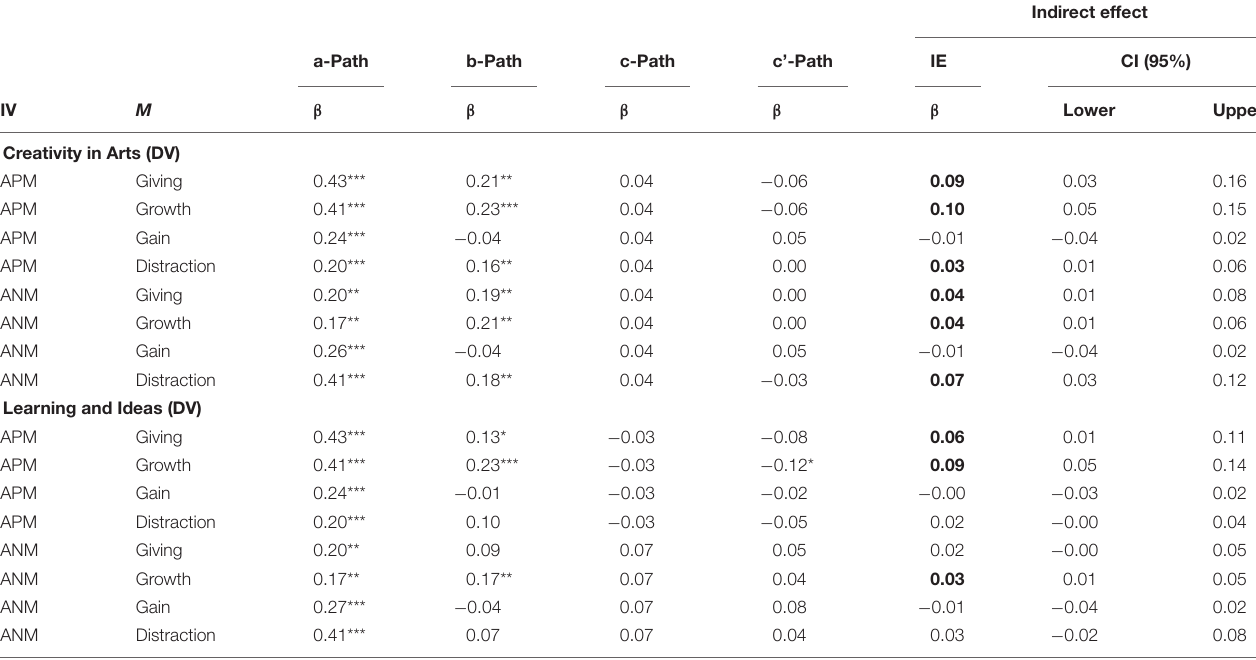
TABLE 8 | Results of the mediation analysis of the effects of moods on change in creativity through motivation in China ( n = 415).